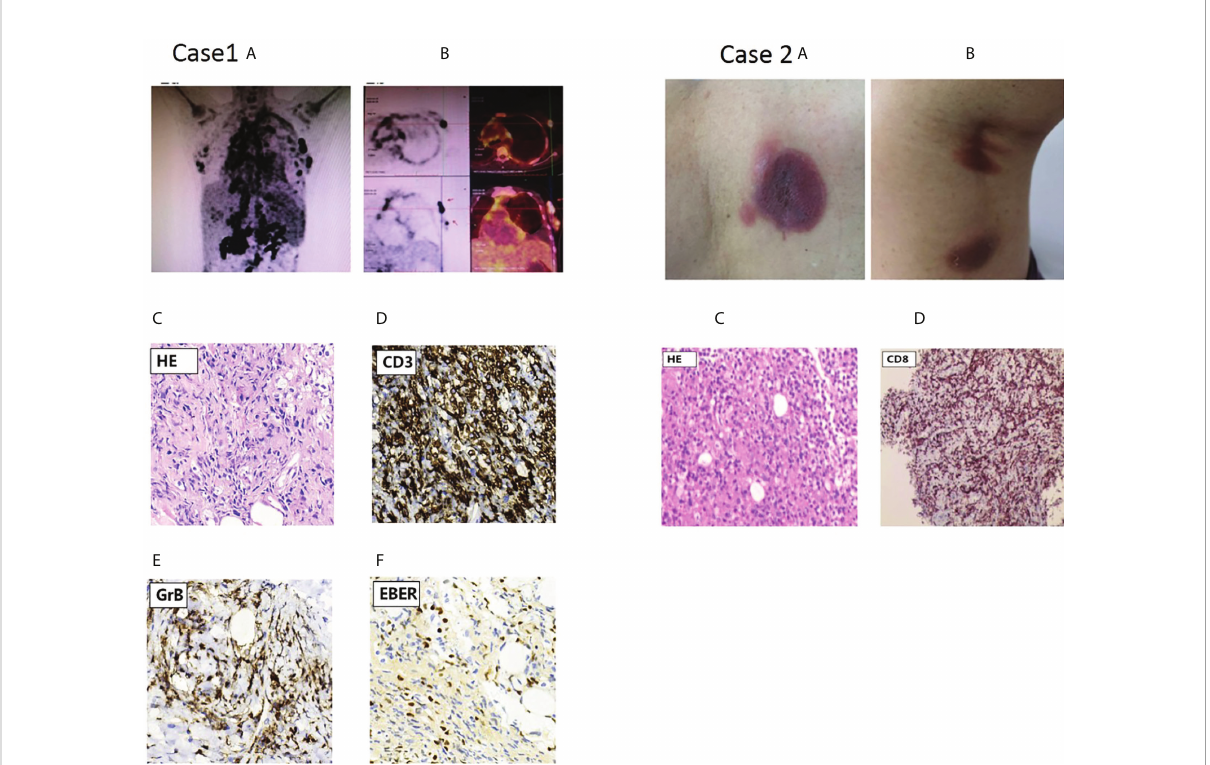
FIGURE 1 PET scan results of the proband in case 1 and skin lesions of case 2 with cutaneous T cell lymphoma(CTCL).Case1 (A) PET scan showing systemic Lymph node enlargement in upper and lower diaphragm and bilateral breast with Lymph node involvement; (B) PET scan pictures of different section indicated involved left breast lymph node with increased FDG metabolism, and arrow points to Hyper-FDG foci and the site of puncture on lymph node. (C-F) Representative pathological and immunohistochemical staining images of EBV-positive peripheral T-cell lymphoma(NOS);c.On H&E(hematoxylin & eosin staining);d,e,f, indicated positive immunohistochemical staining for CD3,GrB and EBER, respectively. Case2: characteristic skin lesions of the patient with CTCL harboring Y82C heterozygous mutation in TIM-3 gene; (A) localized erythema with ulcerated hollow in the left back; (B) two erythema with subcutaneous nodules in left thigh posterior. (C) Primary cutaneous CD8 + T-cell lymphoma: histopathology of section at H&E staining; (D) the tumor cells were positive for